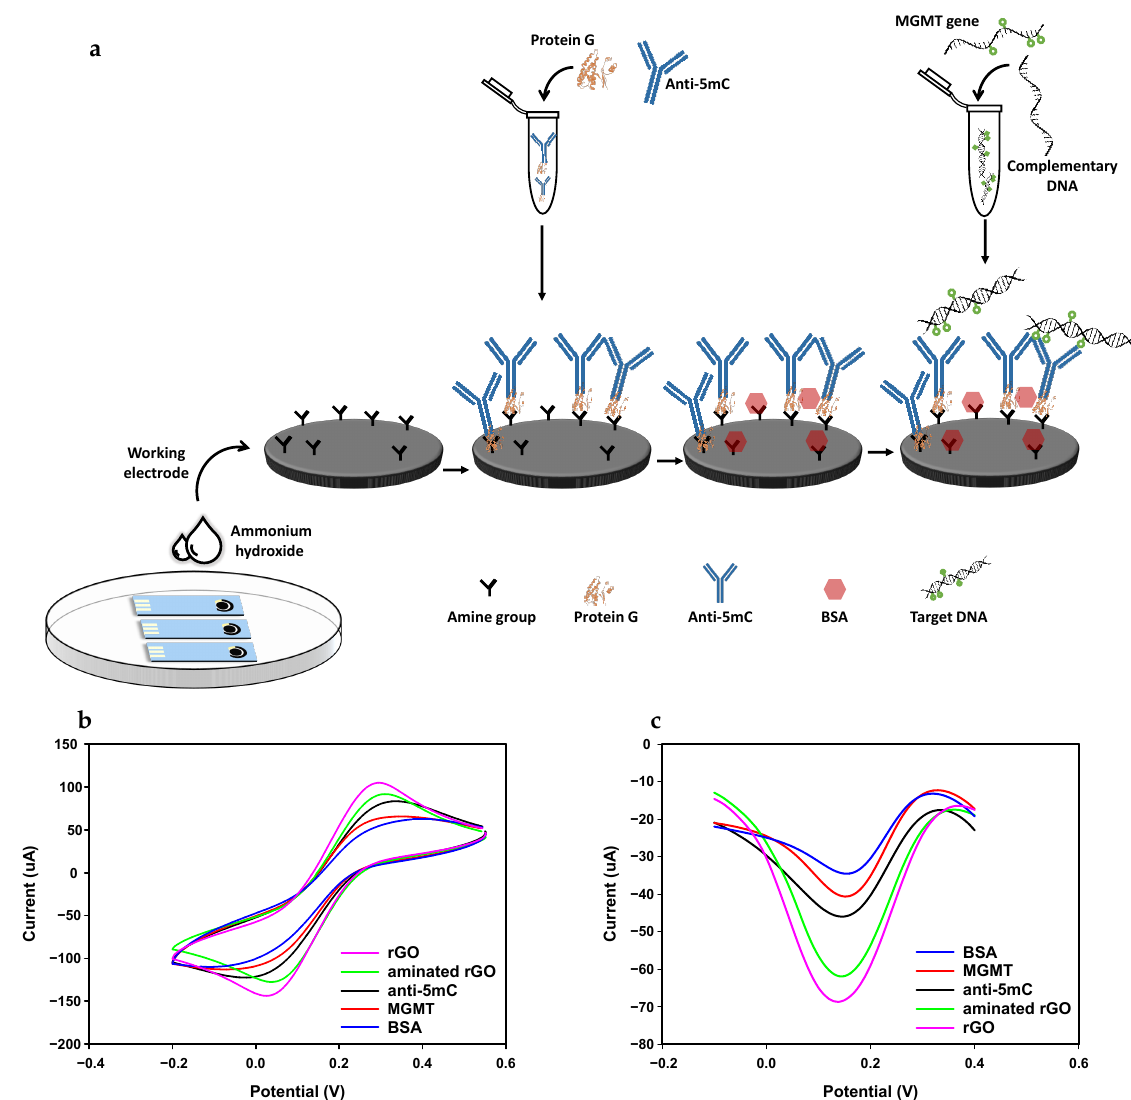
Figure 4. Schematic display of the developed method for the quantification of O-6-methylguanine-DNA methyltransferase (MGMT) oligonucleotide ( a ). Electrodes were incubated in ammonium hydroxide and were kept in a vacuum for further use. Cyclic voltammetry (CV) ( b ) and differential pulse voltammetry (DPV) ( c ) characteristics of the sensor after each assembly steps in 10 mM K 3 [Fe(CN) 6 ] containing 1 M